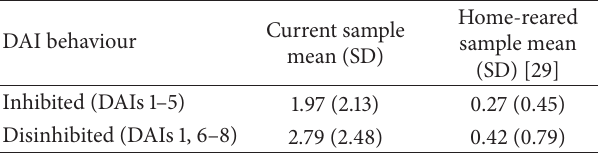
Table 3: Mean scores of DAI ( 𝑛 = 77 ) compared to normative sample ∗